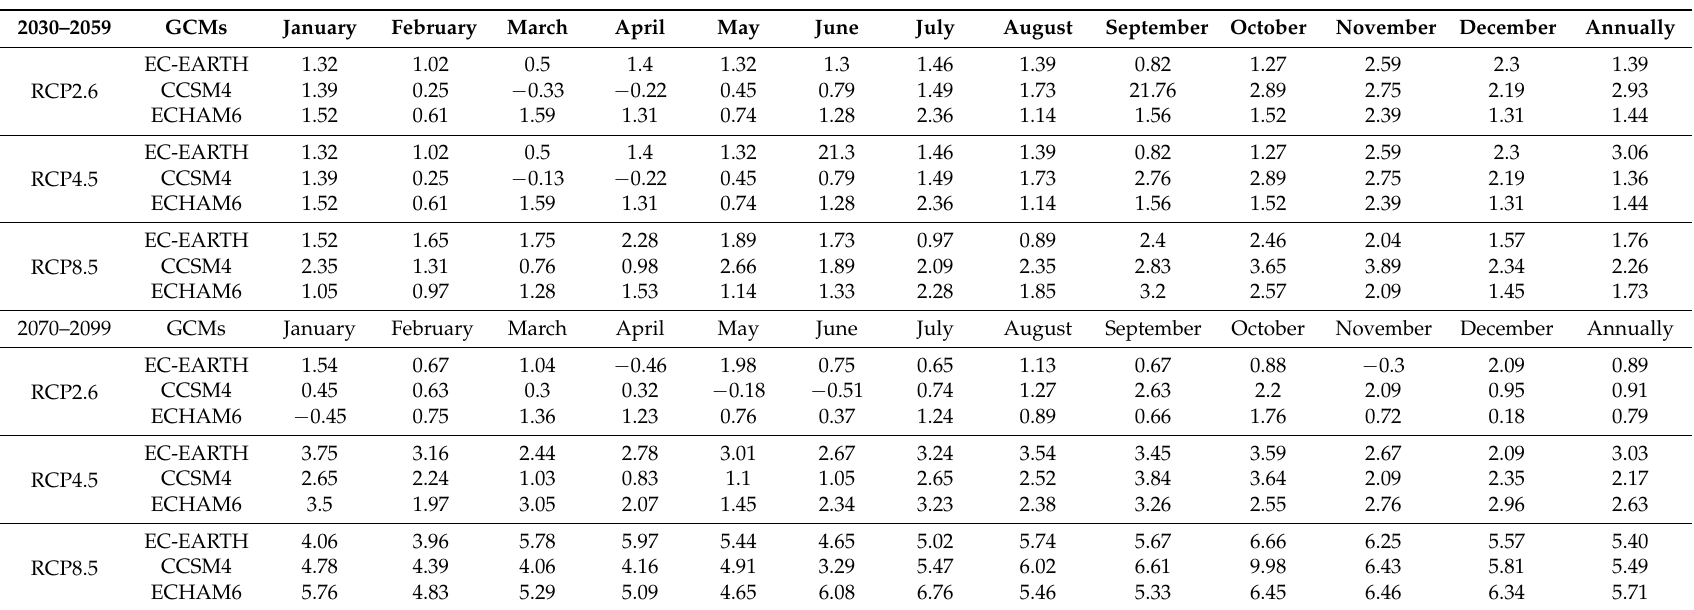
Table 8. Monthly temperature variation ( ◦ C) against control period for our future reference